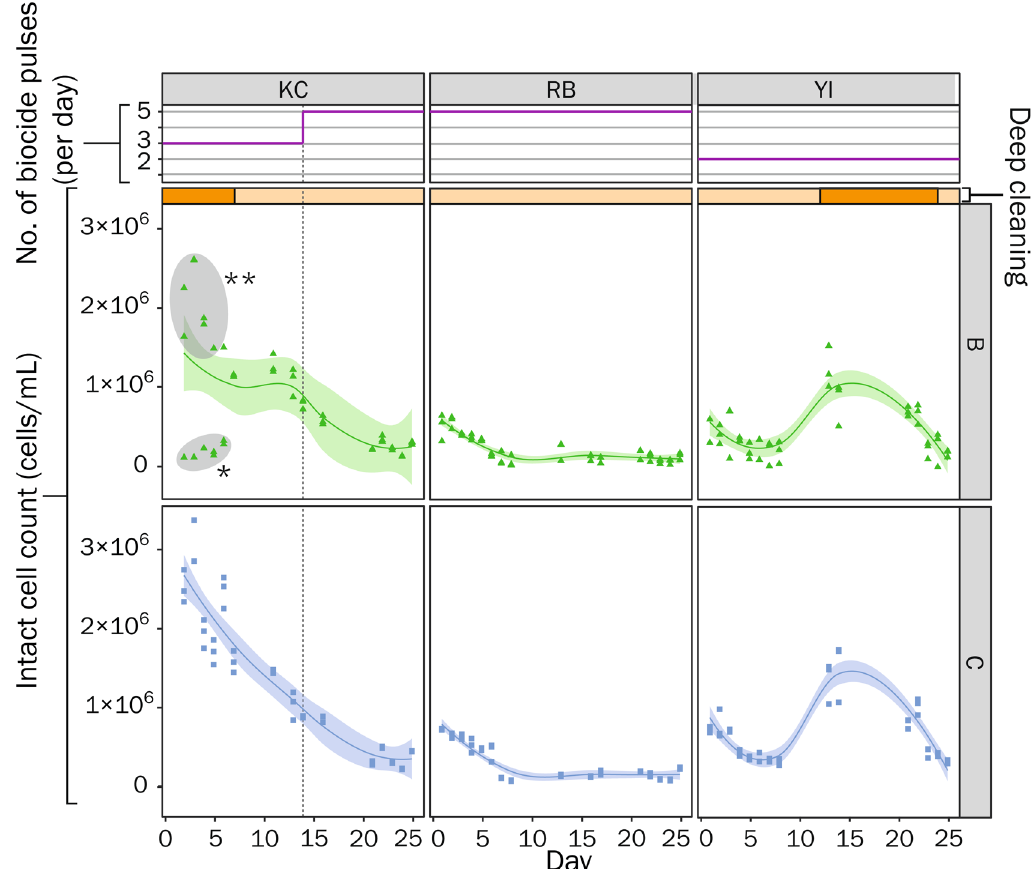
Figure 5. Spatiotemporal dynamics in living cell counts of the planktonic microbial communities in DCPs over the sampling period as they relate to biocide treatments and deep cleaning events. Cytometric counts of living cells (SG + ve counts × proportion of PI +ve events) are shown for sampling points B—cooling tower (CT) basins and C—Condenser outlets across all study plants (KC, RB and YI). Data have been fitted with Loess curves to highlight trends in microbial abundance with time, where the bands show the predicted 95% confidence interval. The incidence of deep cleaning events (wherein biofilms are mechanically removed from the cooling basins) are shown as orange blocks within the yellow bars (deep cleaning at RB was completed approximately 2 weeks prior to the first day of sampling). The line charts below show the number of biocide pulses (40 min treatments with oxidative biocide mixtures) per day. The dotted line through plots of living cells in KC (sites B and C) indicate the sampling day where biocide pulses where increased from 3 to 5 daily treatments. *KC WCT basin samples that were taken from basins that had undergone deep cleaning but not yet been reconnected to the system. **KC WCT basin samples that were taken from WCT blocks that had yet to undergo deep cleaning (> 200 days since